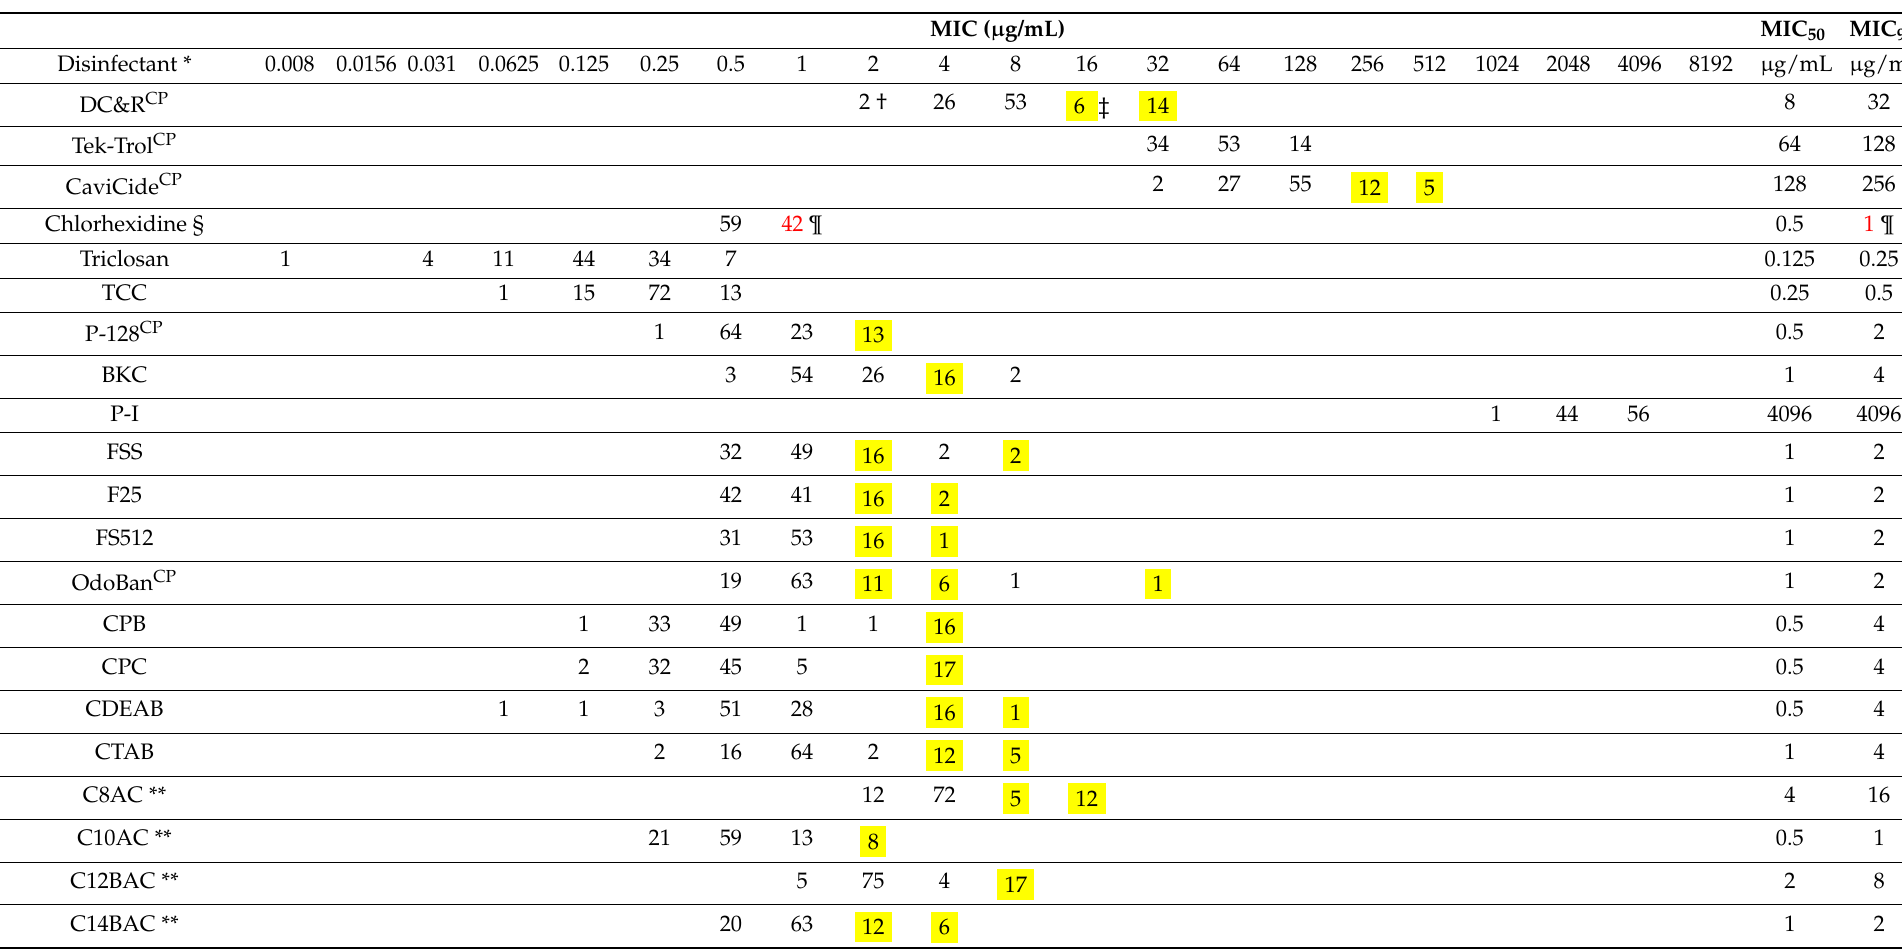
Table 5. Distribution of disinfectant susceptibility profiles for 101 Staphylococcus aureus strains isolated from swine mandibular lymph node tissue and commercial pork sausage meat. MIC = minimum inhibition